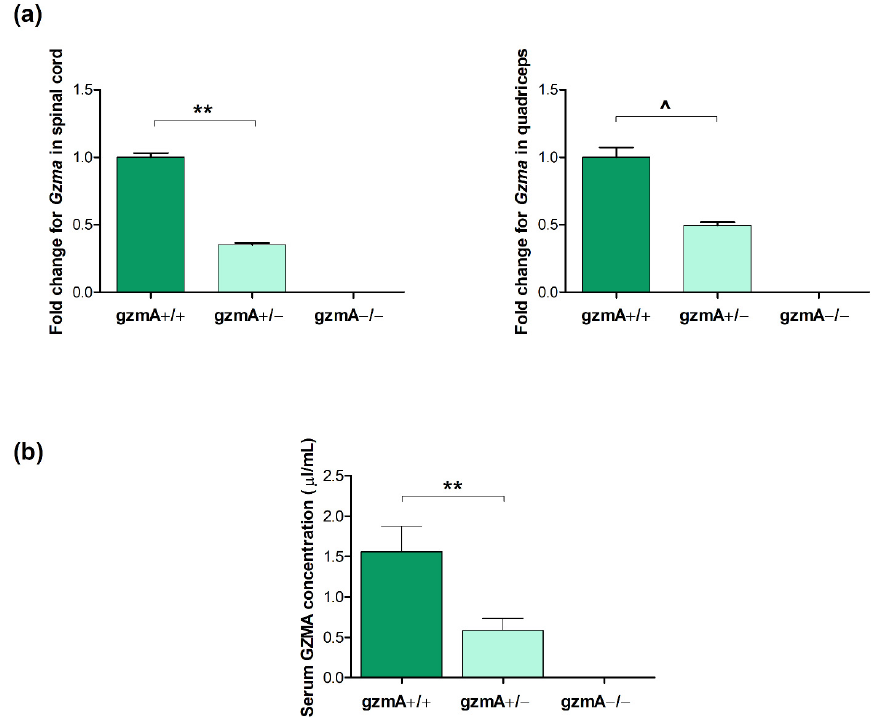
Figure 3. GzmA gene and protein expression in serum, spinal cord and quadriceps from SOD1G93A mice. ( a ) Gzma gene expression was analyzed in spinal cord and quadriceps of 16 SOD1+/ − mice from the survival assay, including gzmA+/+( n = 6), gzmA+/ − ( n = 6) and gzmA − / − ( n = 4) mice. Gzma levels were found downregulated in spinal cord from gzmA+/ − mice compared to the levels found in gzmA+/+ mice ( p = 0.001). Similar tendency was observed in quadricep tissue ( p = 0.076). ( b ) Se- rum gzmA was measured in 33 SOD1+/ − mice at 90 days old, including gzmA+/+ ( n = 7), gzmA+/ − ( n = 14) and gzmA − / − ( n = 12) genotypes. Serum gzmA levels were found reduced in gzmA+/ − mice ( p = 0.005). Bars represent mean ± standard error of the mean. ** p < 0.01, ^ p < 0.10.